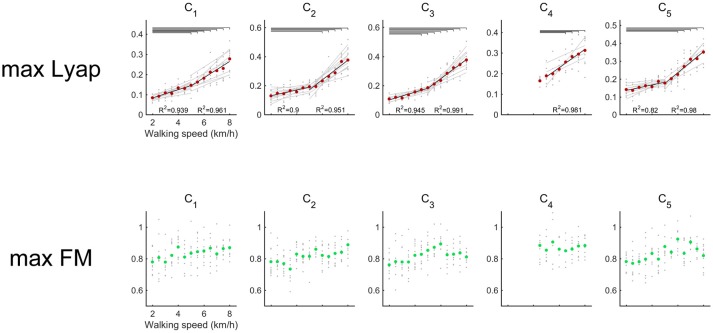
Maximum Lyapunov exponents (upper red) and maximum Floquet multipliers (below green) of the activations of muscle synergy. Gray circles indicate the results of maximum Lyapunov exponents in each subject. Red circles denote the average maximum Lyapunov exponents across all subjects. Black lines represent the average regression lines across the subjects, and gray lines indicate the regression lines for each subject. To detect differences in the increasing rates between slower (2.0–5.0 km/h) and faster walking speeds (5.0–8.0 km/h), the average maximum Lyapunov exponents were regressed separately. The results of R2 are shown in the lower side of each plot. The left R2 represents slower walking speeds, and the right R2 represents faster walking speeds. Upper horizontal lines denote significant differences in the maximum Lyapunov exponents (p < 0.01). Green circles show the average maximum Floquet multipliers across the subjects.